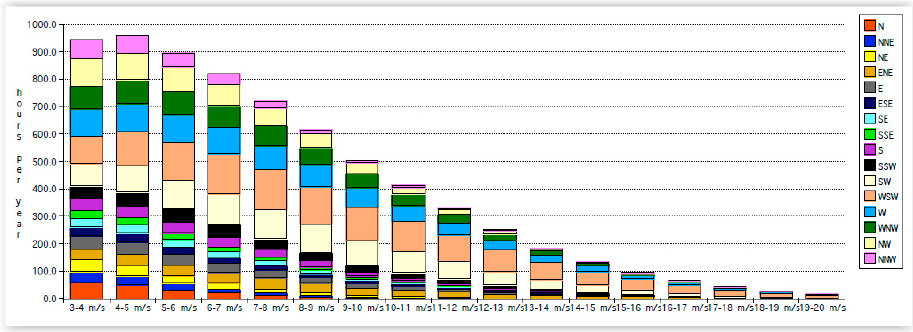
Figure 12. Wind directions for different wind speeds. Figure 13 shows the years when the wind blows within direction ranges. The maxi- mum percentage can be seen in WSW (%16.3), SW (%11.2) and W (%9.7) directions, re- spectively.